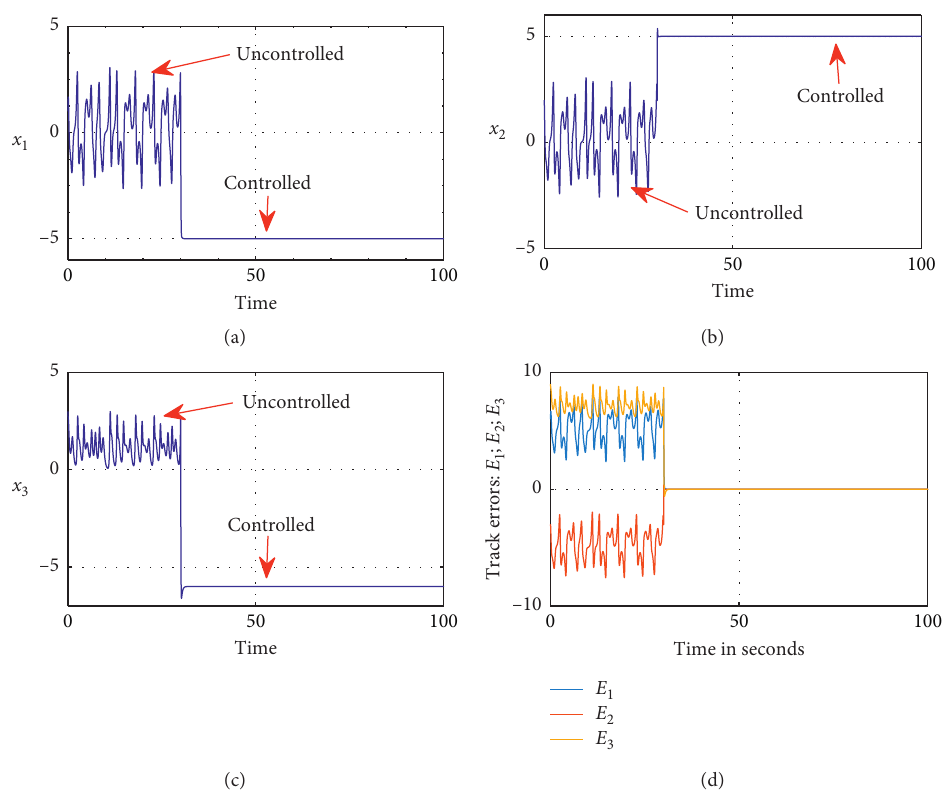
Figure 15: The system response before and after control with x (b) the state variable x